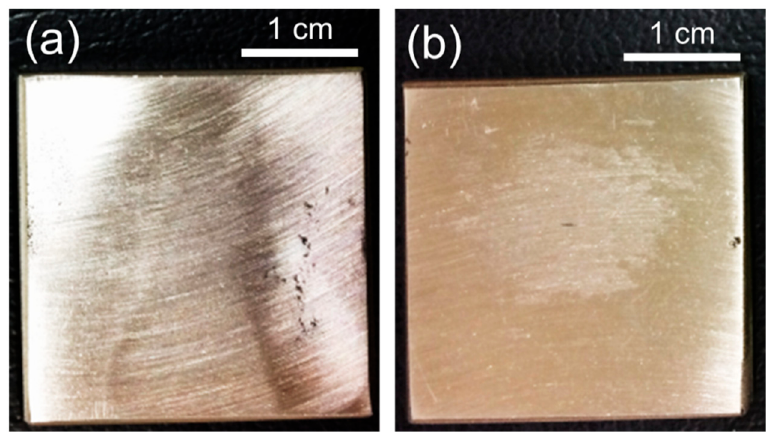
Figure 8. Corrosion morphologies of ( a ) DSS-N and ( b ) DSS-NC after immersion in 6% FeCl 3 + 1% HCl solution at 50 °C for 12 h.